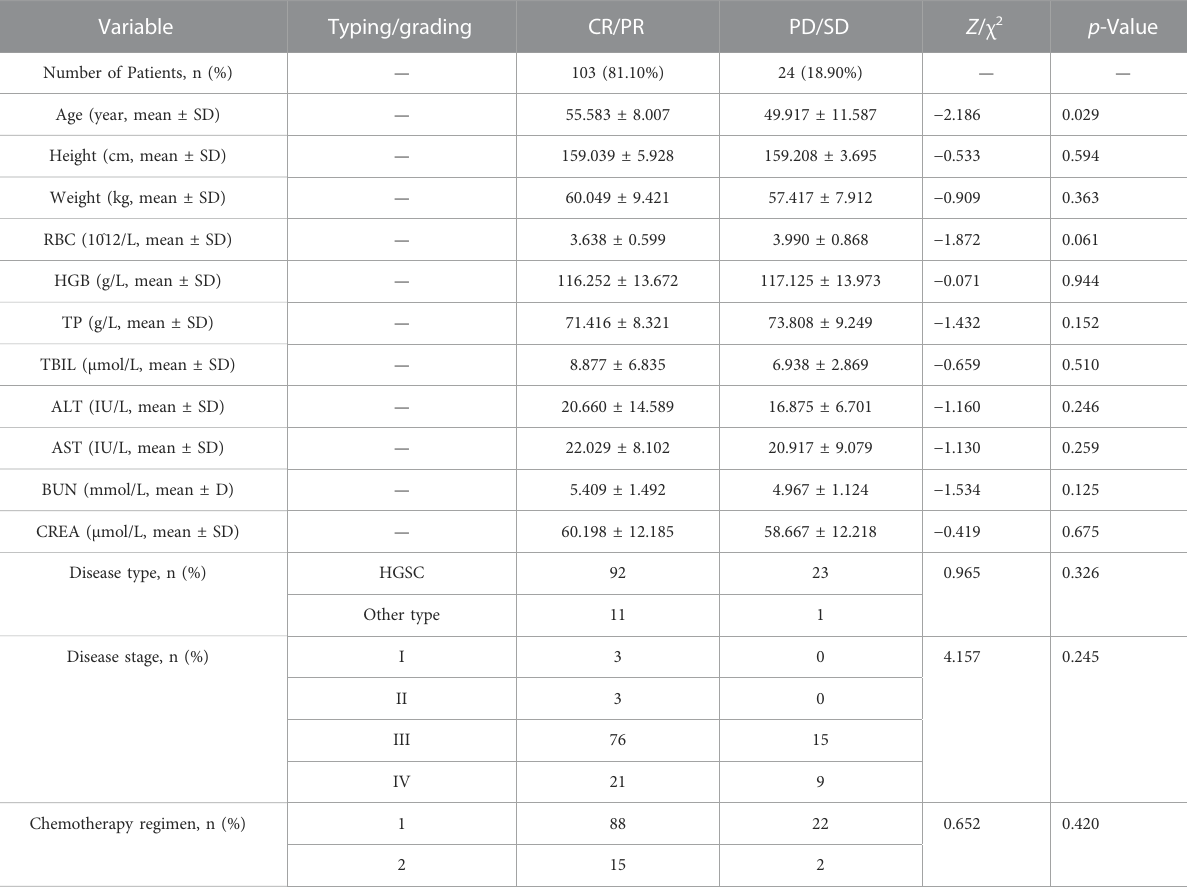
TABLE 4 In fl uence of population factors on the clinical therapeutic effect of carboplatin in patients with ovarian cancer. Variable Typing/grading CR/PR PD/SD Z / χ